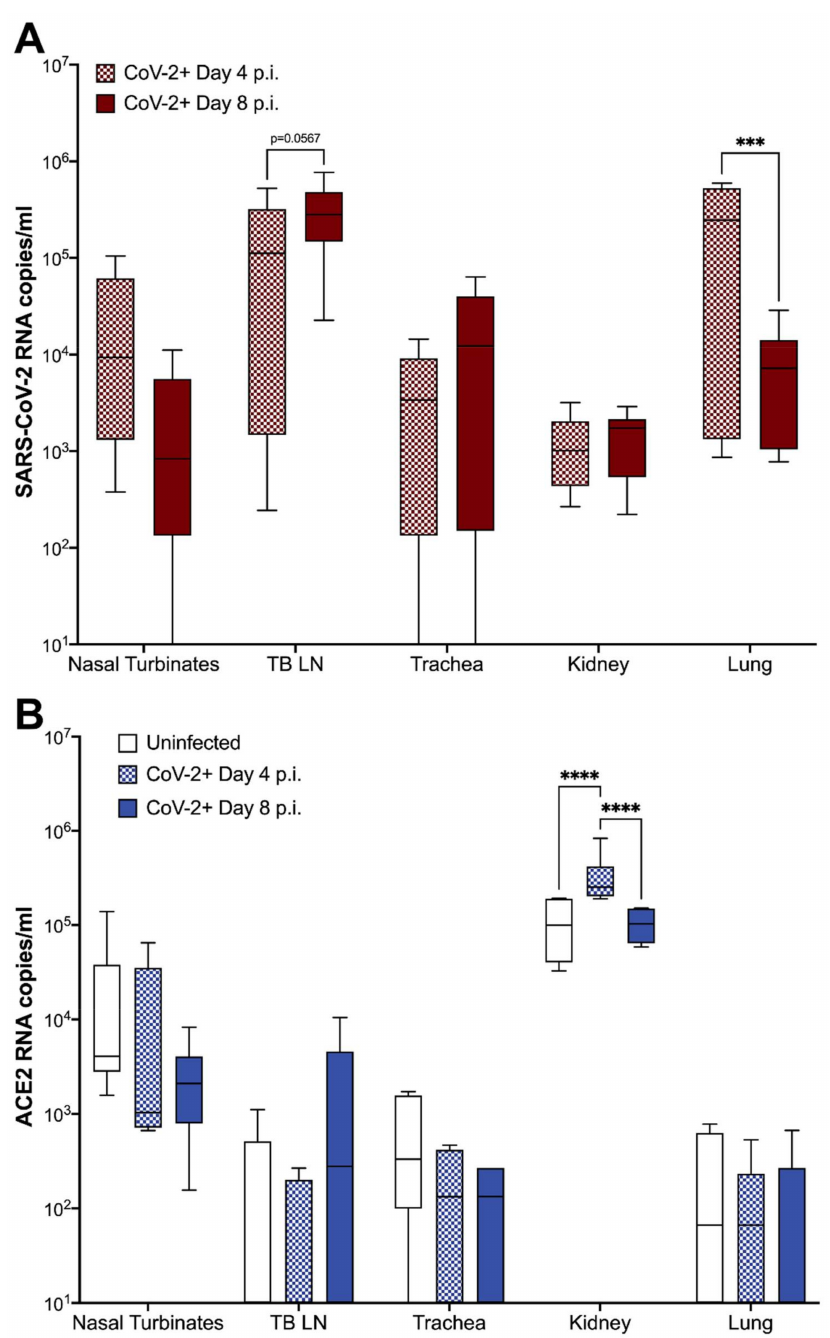
Figure 4. fACE2 RNA and SARS-CoV-2 viral RNA quantification in feline tissues. Extraction of SARS-CoV-2 and ACE2 RNA was performed as described from tissues samples collected at either 4 or 8 dpi. Tissue samples included nasal turbinates, tracheobronchial lymph node (TBLN), trachea, kidney, and lung. ( A ) SARS-CoV-2 RNA copies were detected in all tissues collected from cats inoculated with SARS-CoV-2. No viral RNA was detected in tissues from sham-inoculated cats. In SARS-CoV-2-infected cats, viral RNA copies were slightly increased in the TBLN between 4 to 8 dpi ( p = 0.0567), while viral RNA load in the lungs significantly decreased over the same period ( p = 0.0007). ( B ) fACE2 receptor RNA is significantly increased in the kidney of SARS-CoV-2-infected cats at 4 dpi compared to sham-inoculated controls ( p < 0.0001) SARS-CoV-2-infected cats at 8 dpi ( p < 0.0001). Data are expressed as means ± SEM. n = 6 cats per group. Statistical comparisons made via two-way ANOVA. *** p < 0.001; **** p <